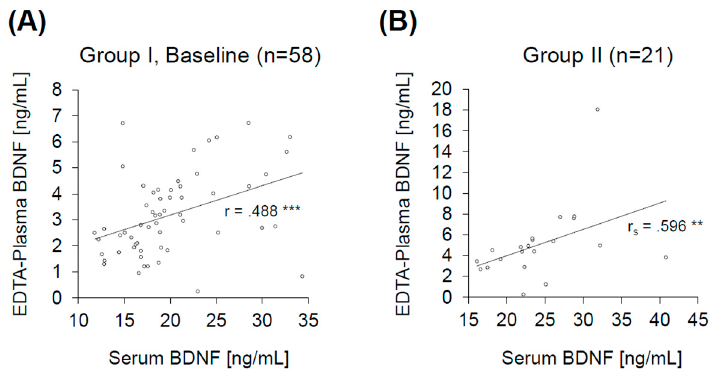
Figure 4. Correlations of serum and EDTA-plasma BDNF in Group I (“Baseline”, T1) ( A ) and Group II ( B ). BDNF: brain-derived neurotrophic factor; EDTA: ethylenediaminetetraacetic acid. ** p < 0.01, *** p < 0.001.